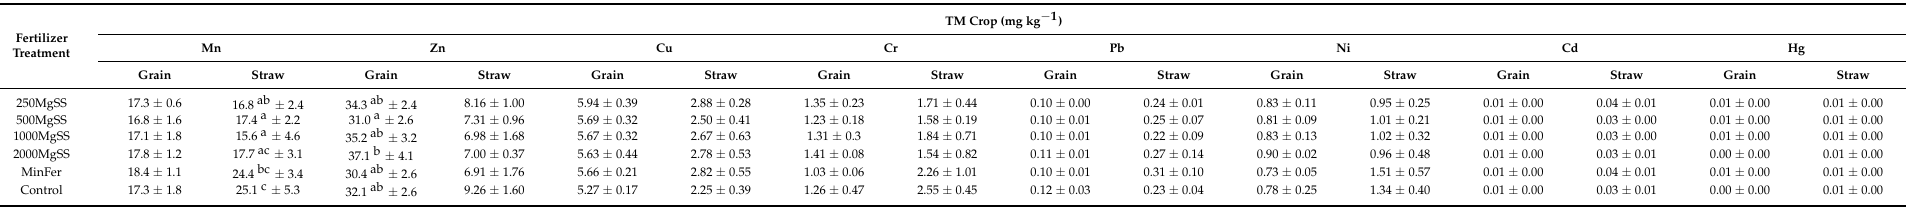
Table 6. Different homogeneous groups in the multiple comparison of two to two means of the concentration of the trace metal Mn, Zn, Cu, Cr, Pb, Ni, Cd and Hg in grain and straw according to the fertilizer treatment received in the study horizon (0–30 cm). Mean ± standard deviations. Values in the same column showing the same letter belong to the same homogeneous group according to Tukey’s test ( p < 0.05).